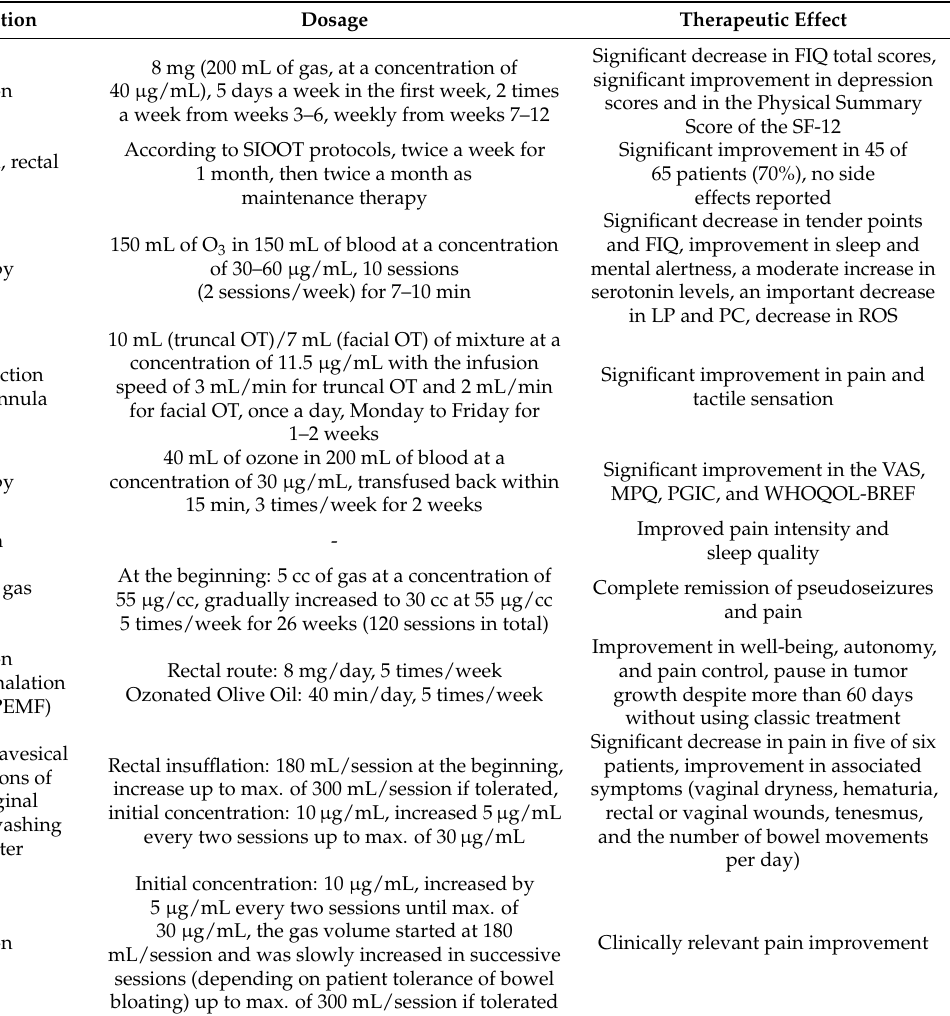
Table 2. Comprehension of reported studies on neuropathic and cancer-related pain treated with